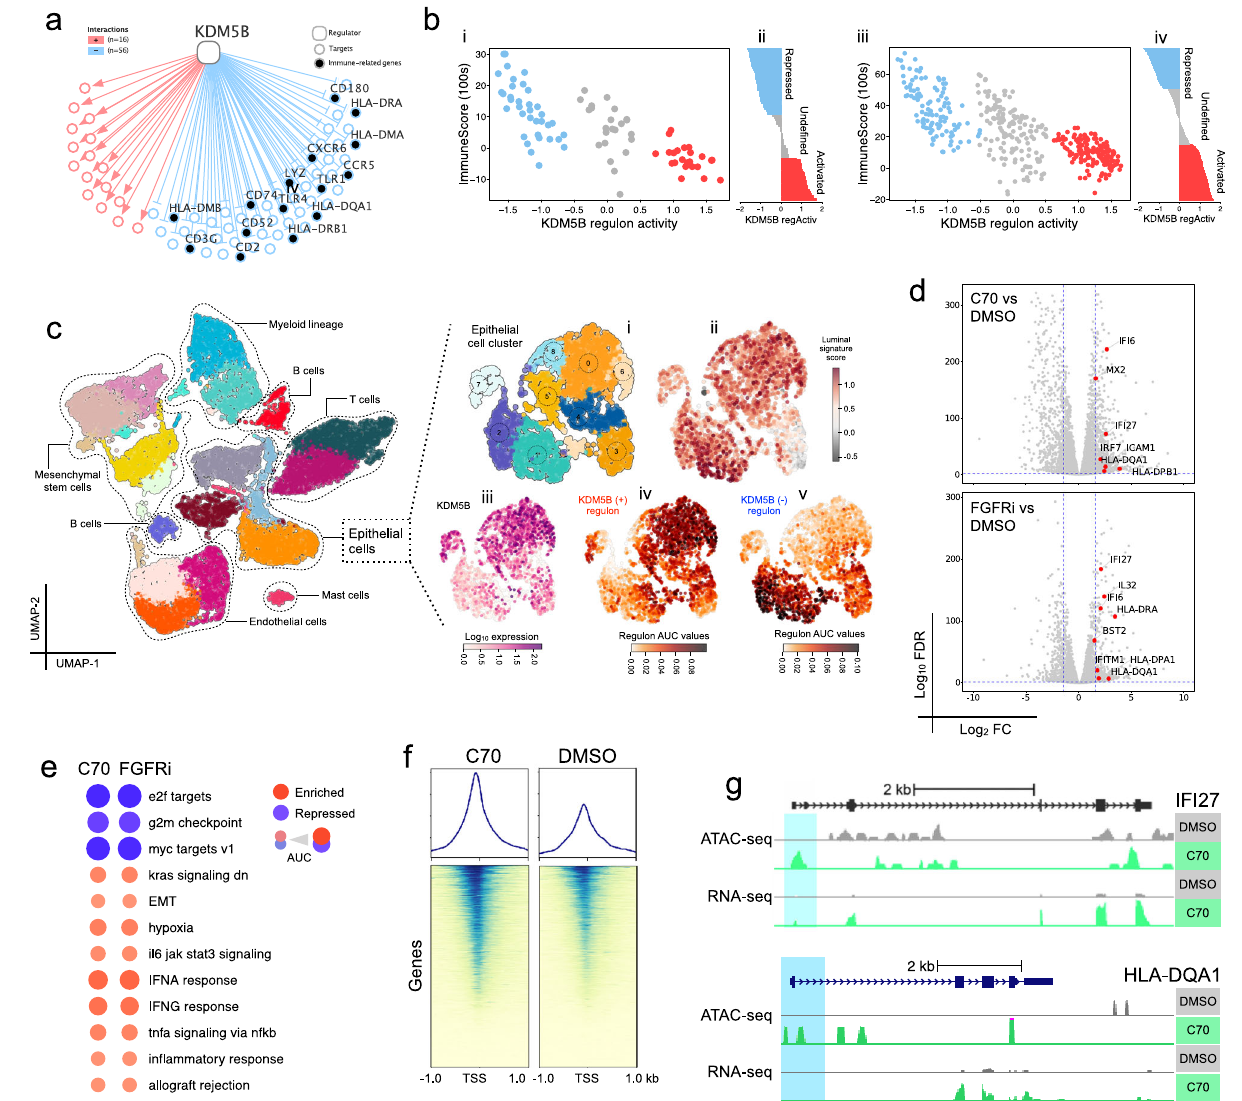
Fig. 6 | KDM5B and FGFR3 are potential therapeutic targets to activate an immuneresponse inS1CPI-MIBCs.a KDM5Bregulontarget genes(red=positive targets,blue=negativetargets),withimmune-relatedgenesmarkedbyblackdiscs. b Validating the negative association between KDM5B regulon activity and ESTI- MATE ImmuneScore. (i) The relationship of KDM5B regulon activity to ESTIMATE ImmuneScoreinthe PURE01 pre-treatmentcohort, with samples (dots) colored by KDM5B regulon activity status. (ii) Rank-sorted pro fi le of KDM5B regulon activity across the PURE01 pre-treatment cohort, showing activated ( n =23, 28%), unde- fi ned ( n =23, 28%), and repressed ( n =36, 43%) cohort subsets. (iii) Relationship of KDM5B regulon activity to ESTIMATE ImmuneScore in the TCGA-BLCA cohort ( n =404).(iv)Rank-sortedpro fi leofKDM5BregulonactivityacrosstheTCGA-BLCA cohort, showing activated ( n =111, 27%), unde fi ned ( n =146, 36%), and repressed ( n =147, 36%) cohort subsets. c Left: Unsupervised clustering of single-cell RNA sequencingdatafromthreehumanMIBCtumorsidenti fi ed19clustersconsistingof